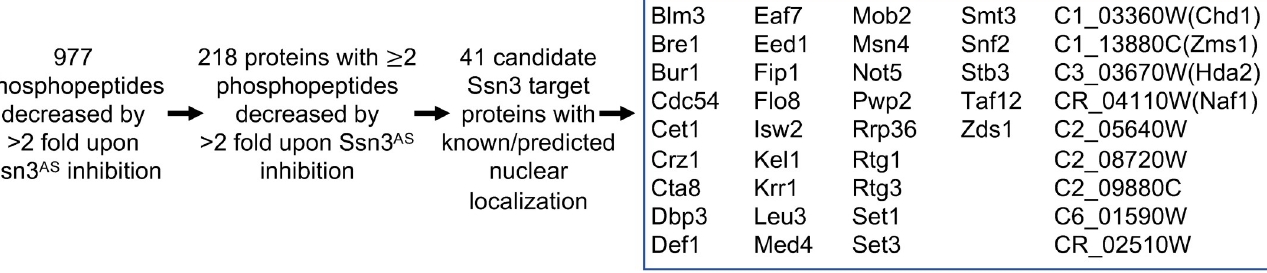
Fig 4. Overview of proteins for which two phosphopeptides were lower by > 2 fold upon inhibition of Ssn3. Focusing on peptides that were significantly lower in Ssn3 AS treated with 3-MB-PP1 relative to control cultures (p < 0.05 FDR-corrected), we found 977 peptides that were 2-fold lower upon 3-MB-PP1 inhibition of ssn3 AS relative to changes in the wild type. Two hundred and eighteen proteins had two more peptides that met these criteria, forty one of which were predicted to have nuclear localization. Med4 is a validated C . albicans Ssn3 target. If an alias is available for an unnamed gene, it is shown in parentheses.